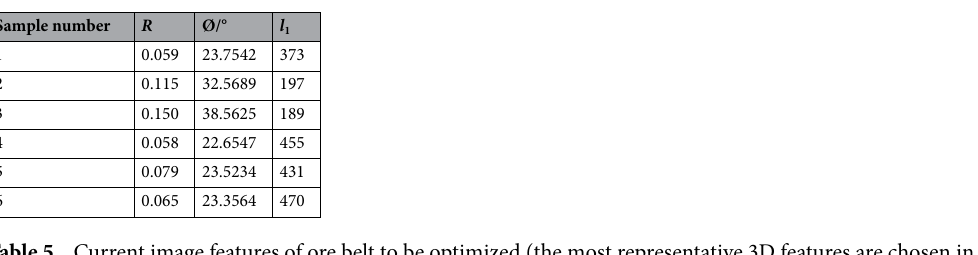
Table 5. Current image features of ore belt to be optimized (the most representative 3D features are chosen in ore belt